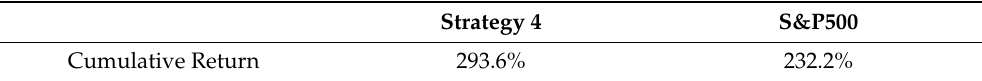
Table 8. Comparison of the cumulative returns of Strategy 4 and the S&P500 in the period from 24 August 2011 to 1 February 2022.